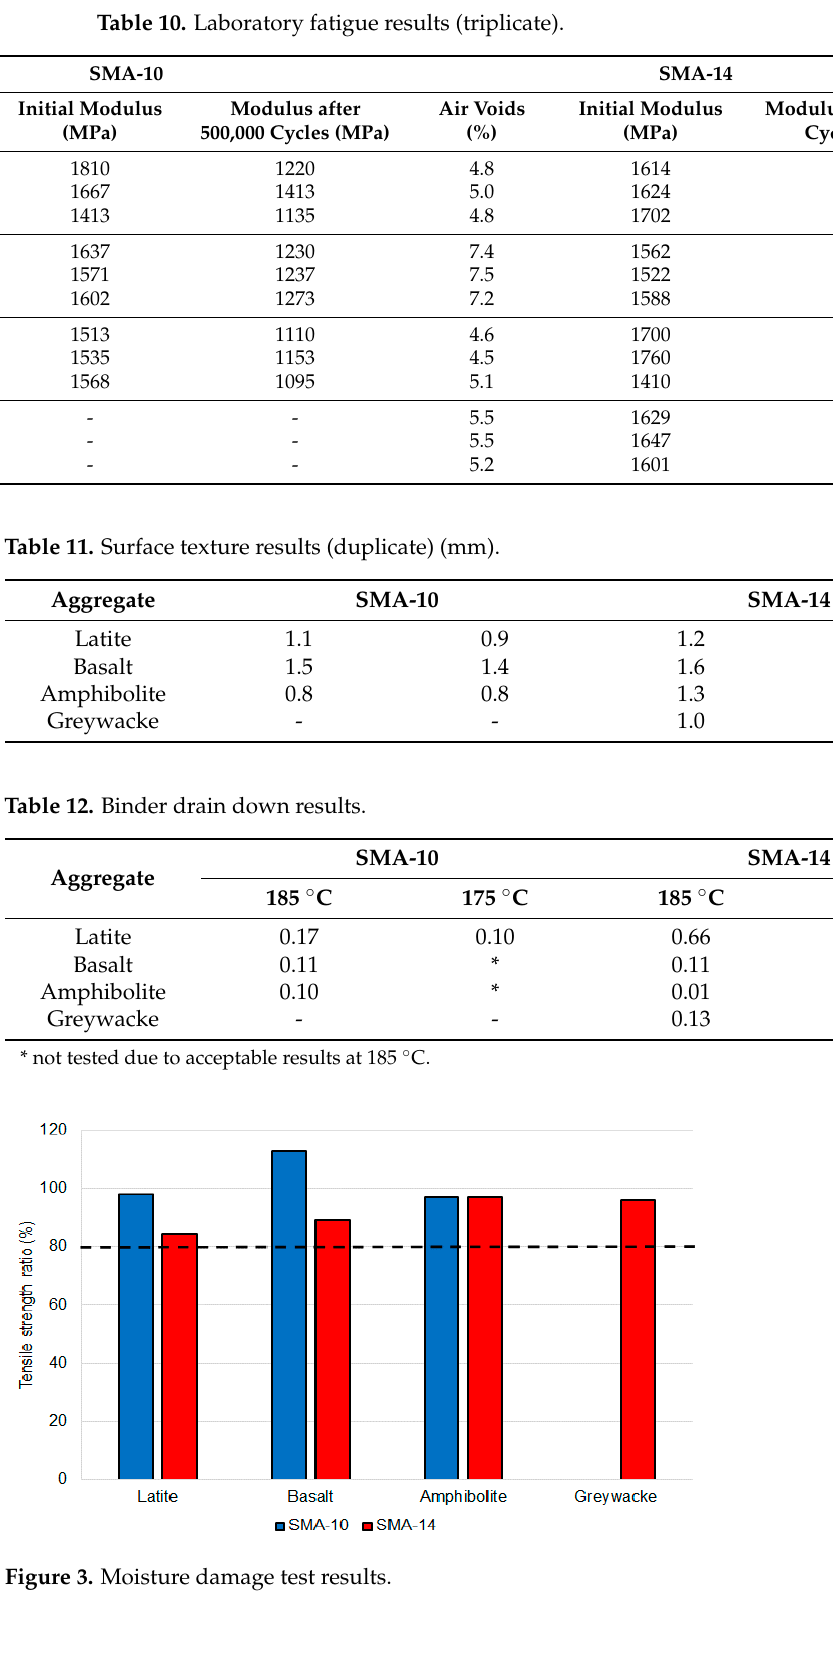
Table 9. Laboratory wheel tracking results (duplicate).